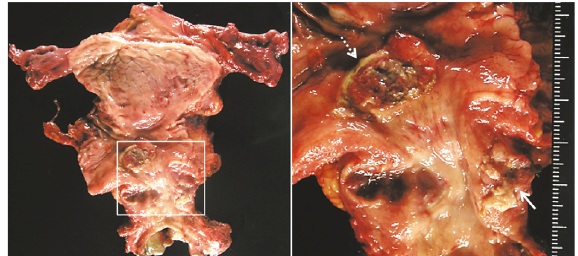
Figure 2: Macroscopic view of excised specimen. On the left is the full specimen and on the right is an enlarged image showing the tumor. The excised specimen had two ulcerated cancer lesions, one (3.0 × 1.8 mm in diameter, dotted arrow) around the trigon of the urinary bladder and the other (2.5 × 3.0 mm in diameter, arrow) on the proximal